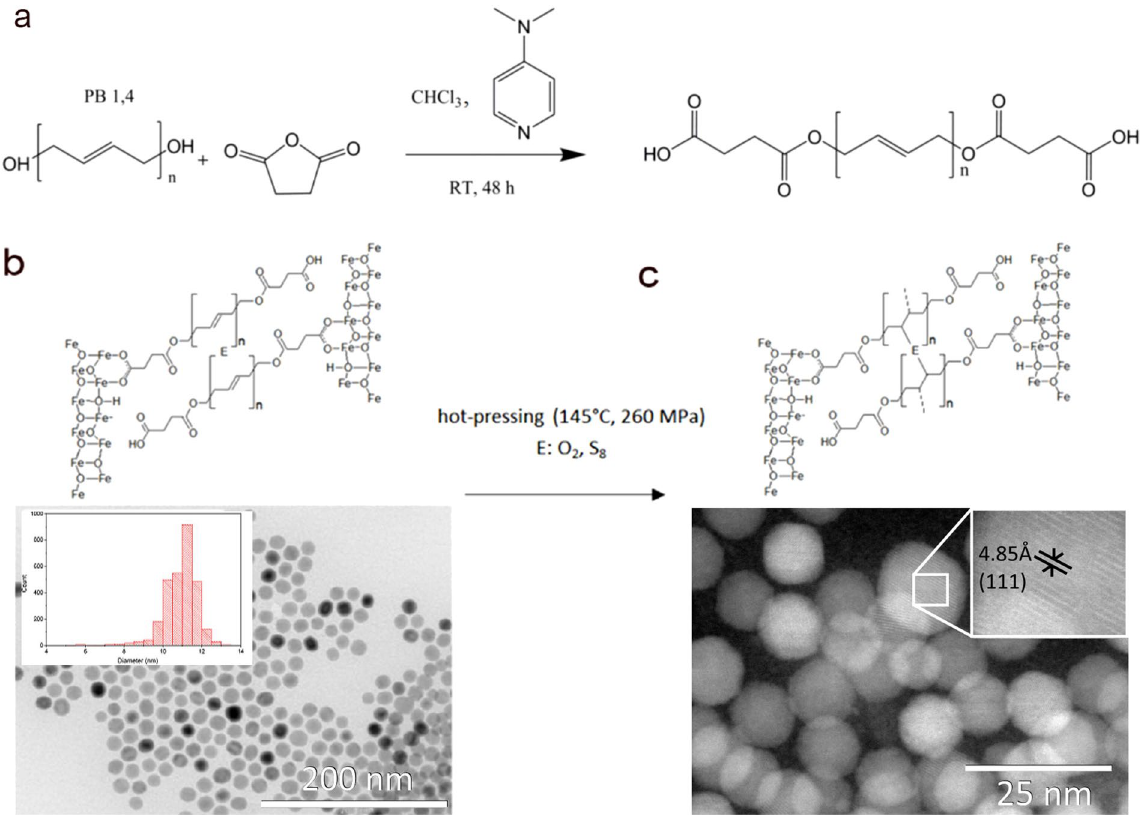
Figure 1. ( a ) End-functionalization of polybutadiene with carboxyl end-functional groups (conversion of α , ω− polybutadiene diol into α , ω -polybutadiene dicarboxylic acid). ( b ) TEM micrographs of the primary 11 nm-sized iron oxide nanoparticles with their corresponding size distribution histogram (insets) and a scheme of their inter-particular spaces. ( c ) After particle sedimentation, drying and hot pressing black pellets